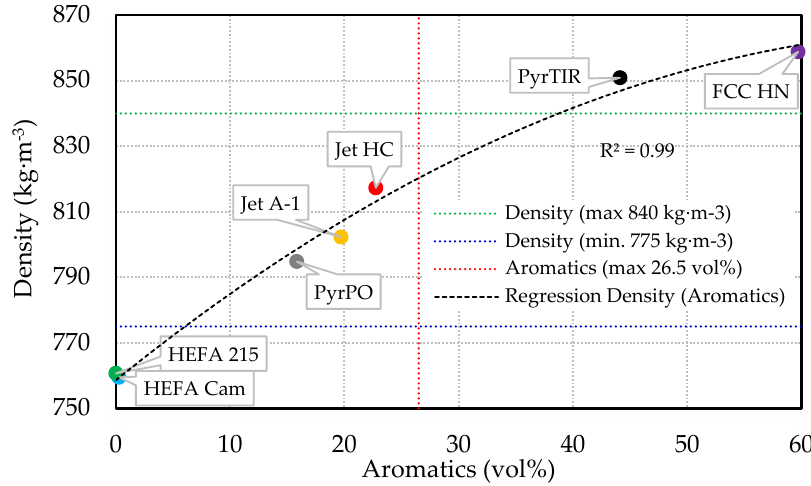
Figure 8. Density relation to the aromatics of the samples studied.